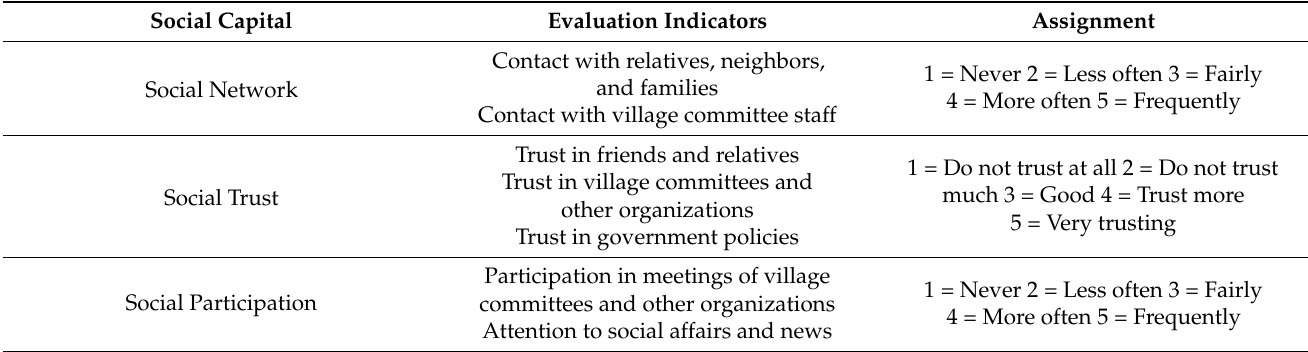
Table 1. Social capital evaluation index system of farm